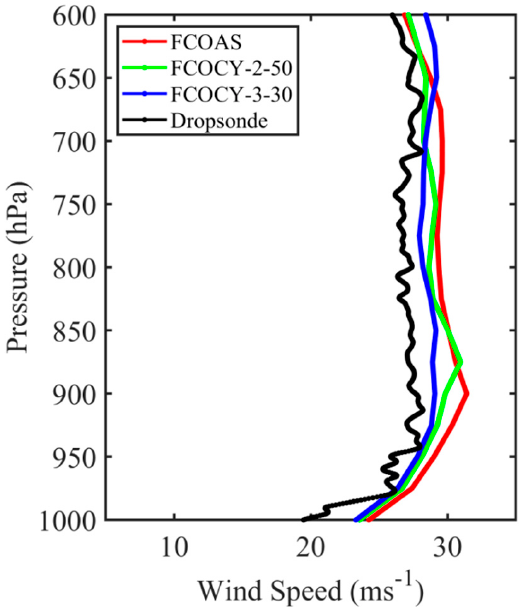
Figure 11. Wind profiles from HWRF forecasts compared with the NOAA P3 aircraft dropsonde at 248 km from the hurricane center for Hurricane Florence at 1200 UTC on 13 September.